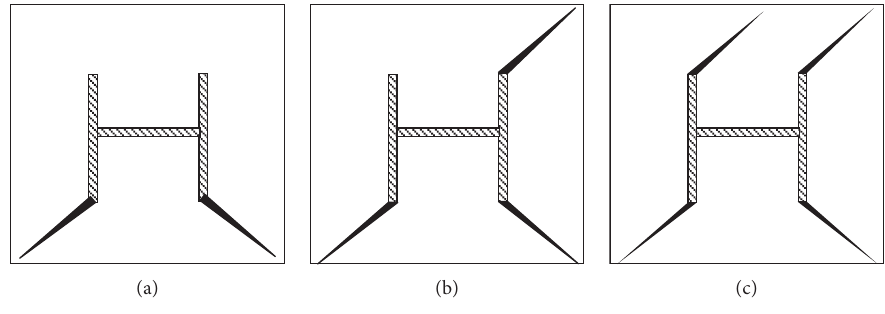
Figure 7: Three main crack distributions at the free